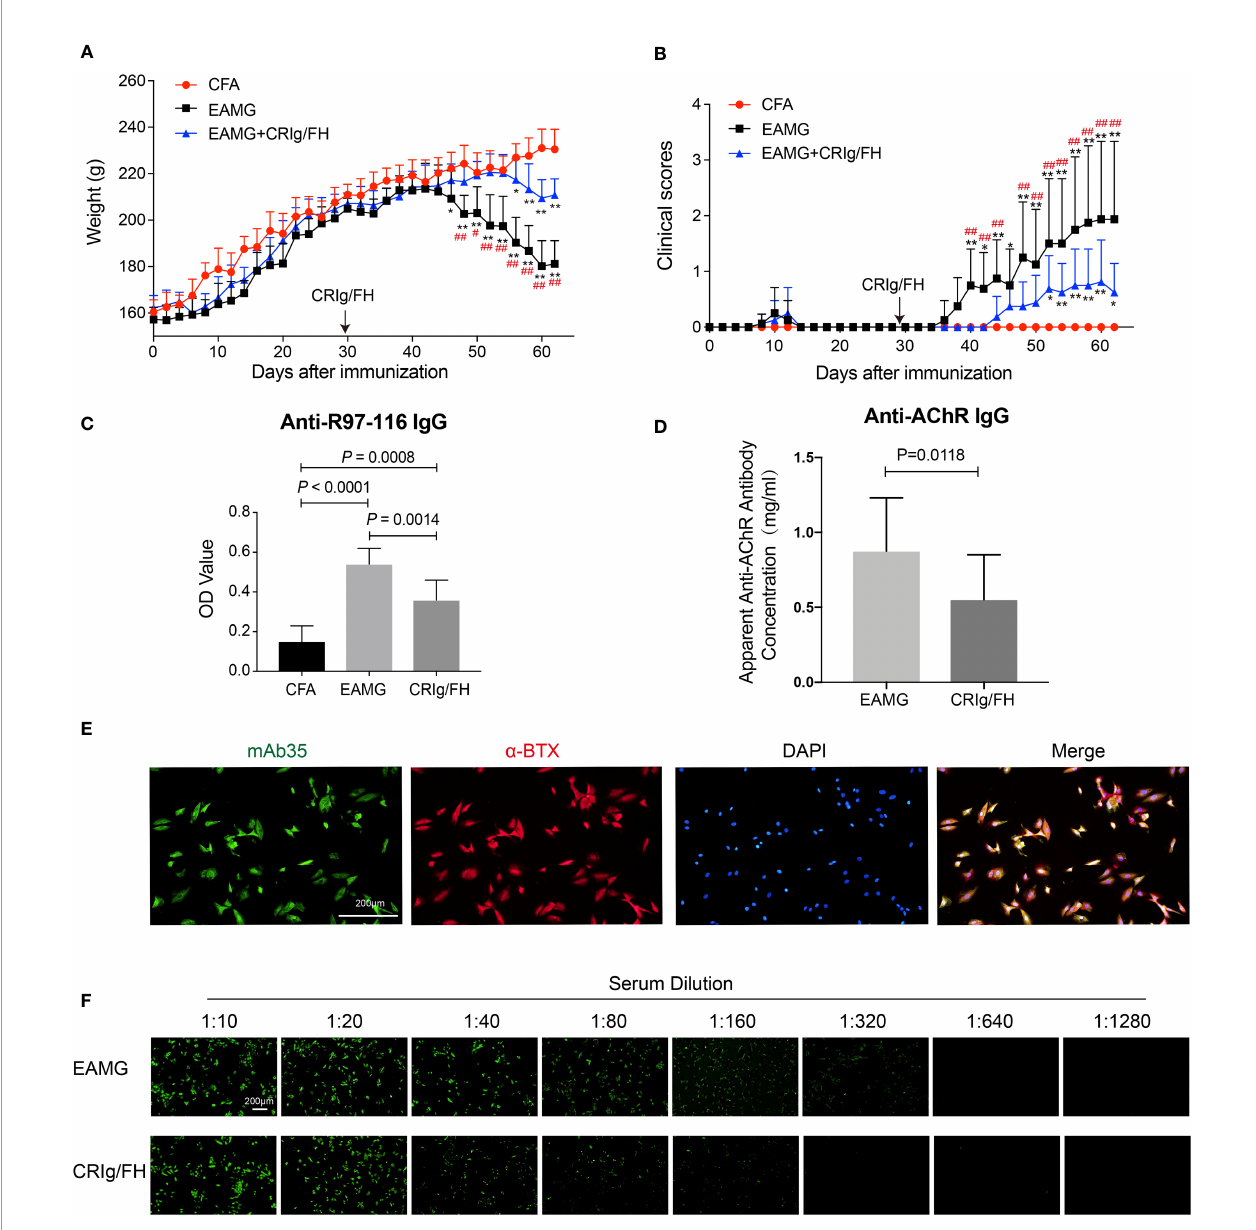
FIGURE 3 | CRIg/FH treatment ameliorates active EAMG and reduces the serum concentration of anti-AChR antibody in rats. (A, B) CRIg/FH ameliorates active EAMG clinical outcomes signi fi cantly. CRIg/FH was injected into active EAMG rats every 3 days from the day before the second immunization (day 29). The rats were sacri fi ced at the 62nd day after the fi rst immunization, and the rat sera were collected. The body weights (A) and clinical scores (B) were recorded every other day. Arrows indicate the days that CRIg/FH were started. (C, D) CRIg/FH reduces the serum levels of auto-antibodies. The serum antibody against AChR 97-116 peptide was measured by ELISA (C) and the apparent anti-AChR antibody concentration was determined by immuno fl uorescence with H9c2(2-1) cells expressing rat muscle AChR, corresponding to a concentration of mAb35, which gives an equivalent fl uorescent signal on H9C2(2-1) cells (D) . Data are presented as mean ± SD (A – D) ; n = 8/group; two-way ANOVA (A, B) , one-way ANOVA (C) with Tukey ’ s multiple comparison test or Student ’ s t -test (D) ; * p < 0.05, ** p < 0.01, signi fi cant differences compared with the CFA group at each indicated time point; # p < 0.05, ## p < 0.01, differences between active EAMG and active EAMG+CRIg/FH groups at each time point. Results are representative of three independent experiments repeated with similar results. (E) Stable expression of rat AChR subunits in H9c2(2-1) cells. H9c2(2-1) cells were incubated with anti-AChR mAb35 (21.7 m g/ml) and stained for rabbit anti-rat IgG conjugated with Alexa Flour 488 (green), AChR (identi fi ed by a -Bungarotoxin; red), and 4 ′ ,6-diamidino-2-phenylindole (DAPI; blue). Scale bars, 200 m m. (F) Immuno fl uorescence assay endpoint titer results for serum samples against rat AChR subunits in H9c2(2-1) cell. H9c2(2-1) cells were incubated with serum samples at dilution titers from 1:10 up to 1:1,280 and stained for rabbit anti- rat IgG conjugated with Alexa Flour 488 (green). Scale bars, 200 m